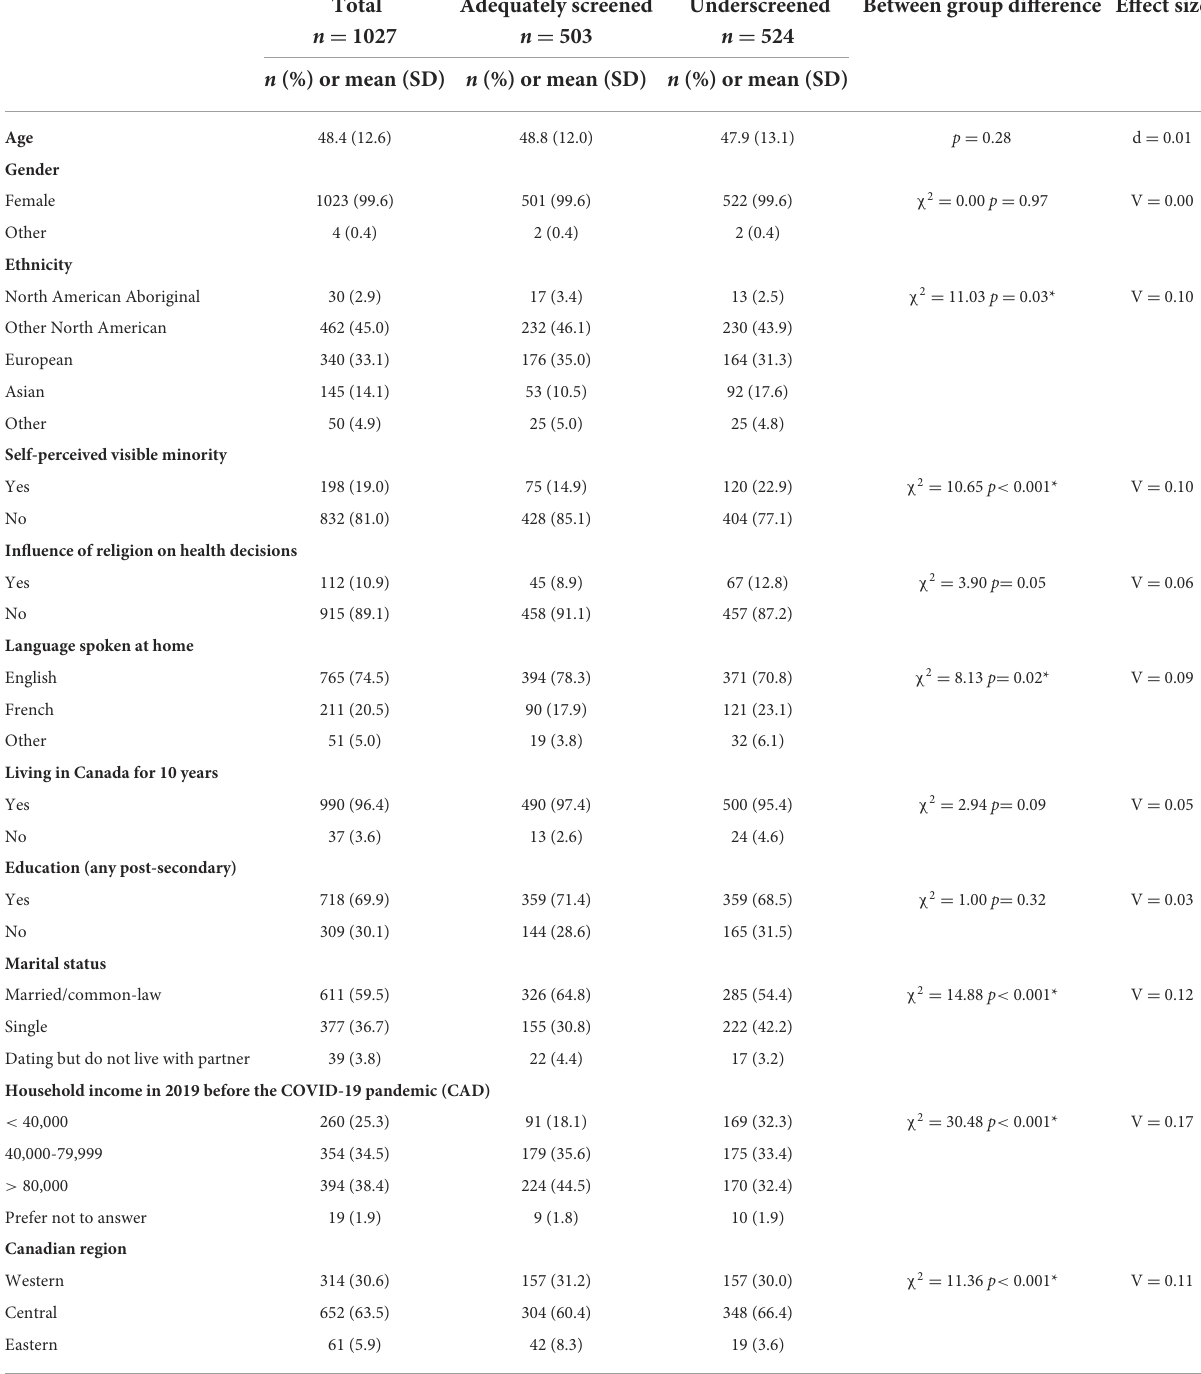
TABLE 1 Socio-demographic variables. Total Adequately screened